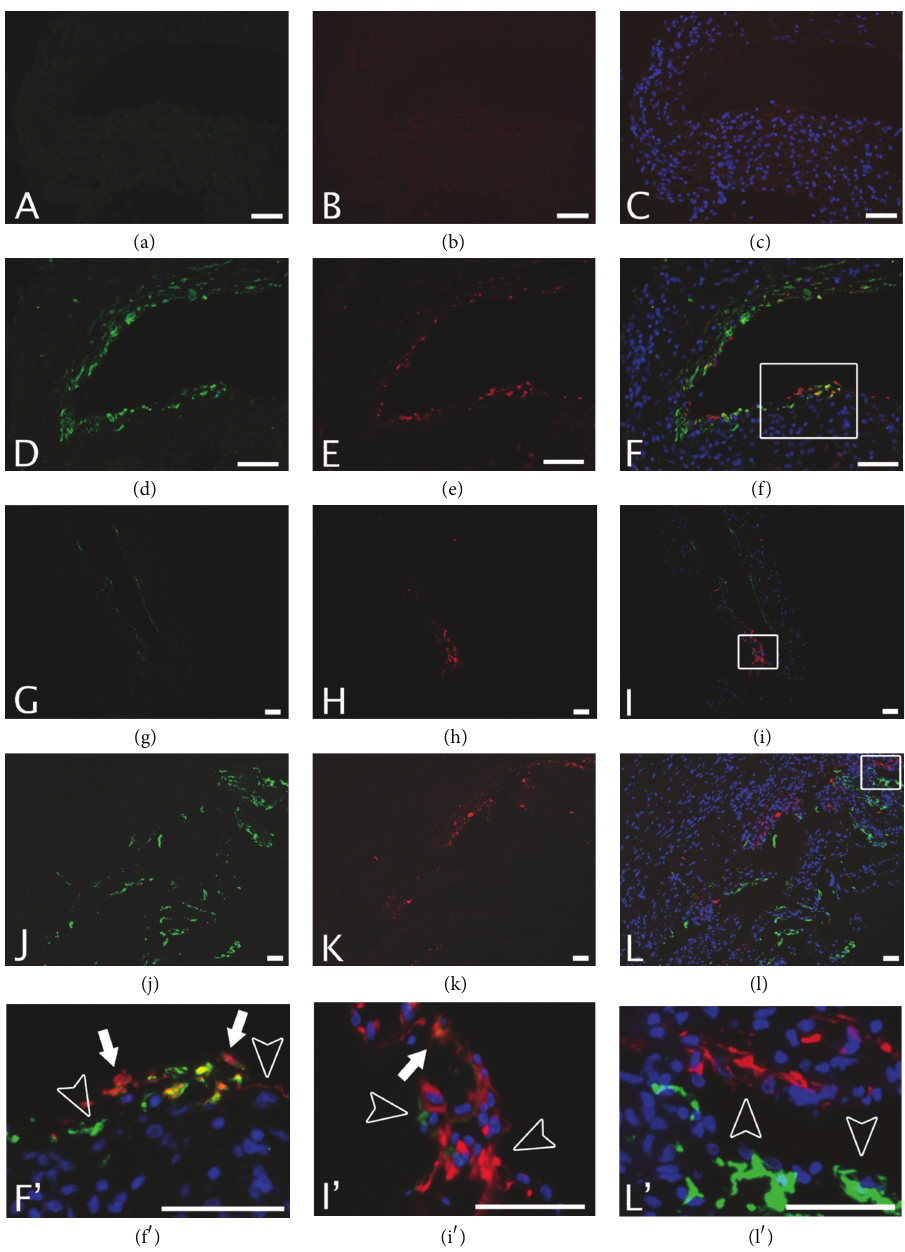
Figure 3: AQP1 expression colocalized with 𝛼 SMA and GFAP. First row of images represents the negative control (a–c), respectively, in green, red, and blue (DAPI stains the cell nuclei). (d) AQP1 expression in green; (e) 𝛼 SMA expression in red; (f) AQP1 and 𝛼 SMA colocalisation (merge of (d) and (f) images) and DAPI; (g) AQP1 expression in green; (h) GFAP expression in red; (i) AQP1 and GFAP colocalisation (merge of (g) and (h) images) and DAPI; (j) GFAP expression in green; (k) 𝛼 SMA expression in red; (l) lack of GFAP and 𝛼 SMA colocalisation (merge of (j) and (k) images) and DAPI. (f 󸀠 ), (i 󸀠 ), and (l 󸀠 ) represent a high magnification of the white square, respectively, drawn in the (f), (i), and (l) picture. Empty arrowheads designate single marker (AQP1 or 𝛼 SMA or GFAP), while solid arrow point out coexpression of AQP1/ 𝛼 SMA (f 󸀠 ) or AQP1/GFAP (i 󸀠 ). There was no colocalisation between GFAP and 𝛼 SMA in the (l 󸀠 ) picture. Empty arrowheads designate cells labelled by a single marker, either GFAP in green or 𝛼 SMA in red (l 󸀠 ). Scale bars represent 50 𝜇 m.